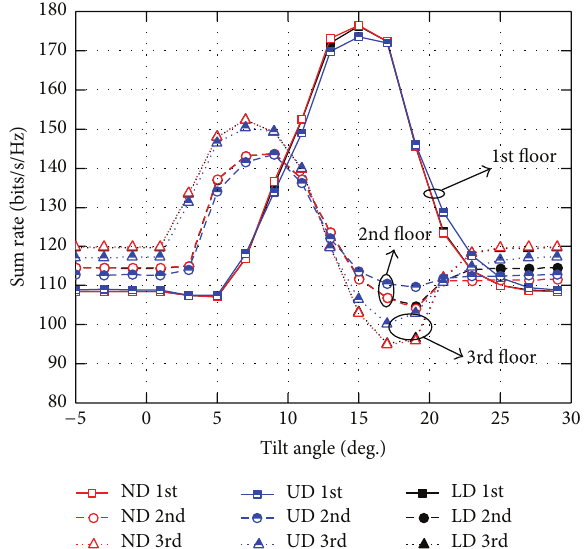
Figure 5: Simulated sum rate against tilt angle for three user distributions ( 𝑝 𝑢 = 5 dB, 𝑁 𝑟 = 50 , 𝑁 𝑡 = 2 , 𝐿 = 3 , 𝐾 = 24 , 𝐷 = 200 m, 𝜐 = 4 , UD: uniform distribution, ND: normal distribution, and LD: linear distribution).